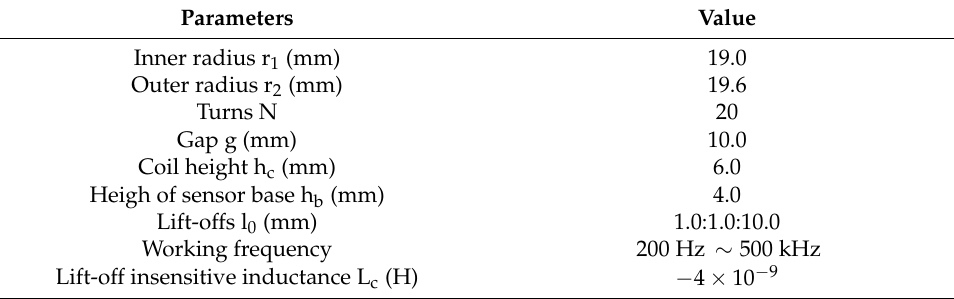
Table 2. Properties of sensor structures and excitation